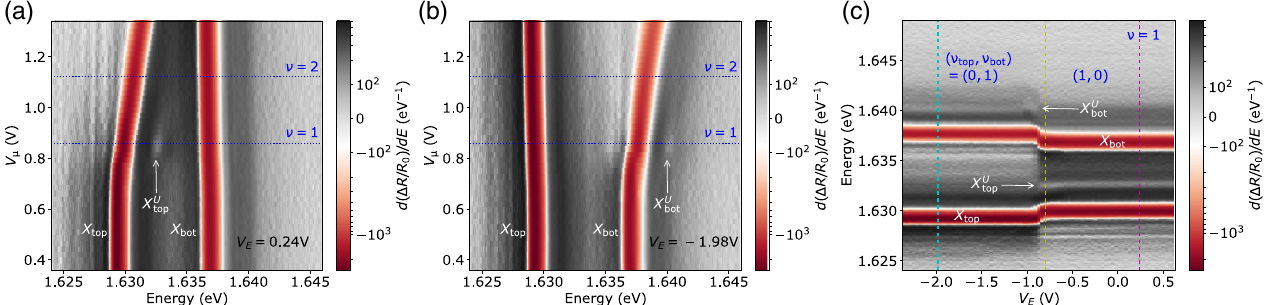
FIG. 2. Umklapp exciton resonances at ν ¼ 1 . (a),(b) V μ dependence of differential reflectance differentiated with respect to energy E ¼ 0 . 24 V (a) and V ¼ − 1 . 98 V (b). (c) V at V dependence of differential reflectance spectra at ν ¼ 1 . The cyan, yellow, and E E E ¼ − 1 . 98 , − 0 . 80 , and 0.24 V, respectively. The scale of the color bars is logarithmic for magenta dashed lines correspond to V E Þ =dE j > 10 2 eV − 1 and linear for j d ð Δ R=R Þ =dE j < 10 2 eV − 1 j d ð Δ R=R 0 0